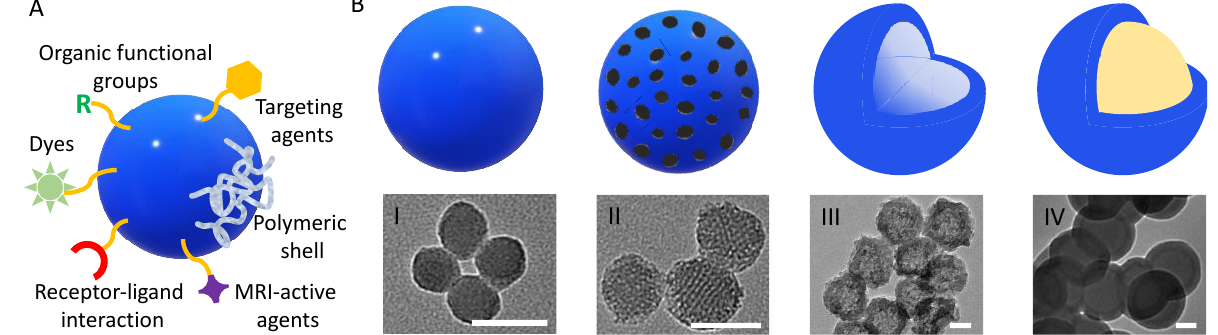
Figure 1. Schematic illustration of silica-based nanomaterials. ( A ) SiO 2 NPs as multifunctional nanoplatforms. ( B ) Structural morphology: I: nonporous Stöber SiO 2 NPs, II: mesoporous SiO 2 NPs (MSN), III: hollow SiO 2 NPs, and IV: core-shell SiO 2 NPs. III and IV can also be porous silica shells. I-IV can be a stimuli-responsive silica framework. Scale bar: 50 nm .